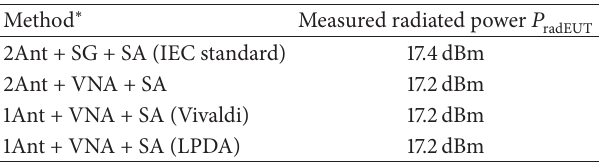
Table 1: Comparison of measured radiated power using three methods.